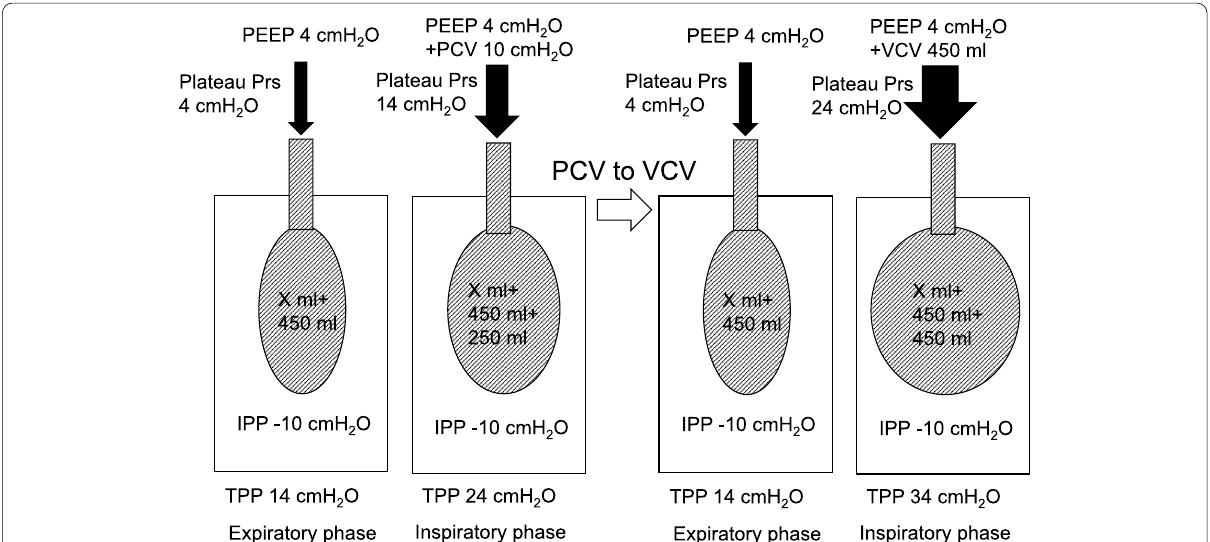
Fig. 3 The phenomenon happened after switching pressure control ventilation to volume control ventilation. The left side of the figure shows the lung state during PCV with drainage. The right side of the figure shows the lung state after switching PCV to VCV. In case of VCV, 450 ml of TV forced lung volume to increase from X 450 ml to X 450 450 ml, which increased plateau pressure to 24 cmH 2 O because of more increased + + + elastance by more overextension. PEEP , positive end-expiratory pressure; Plateau Prs, plateau pressure; PCV , pressure control ventilation; VCV , volume control ventilation; IPP , intrapleural pressure; TPP , transpulmonary